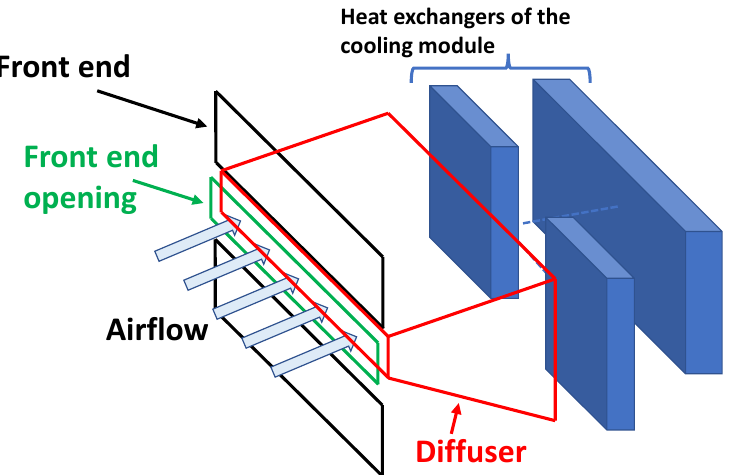
Figure 3. The vehicle cooling module with the suggested diffuser integration .